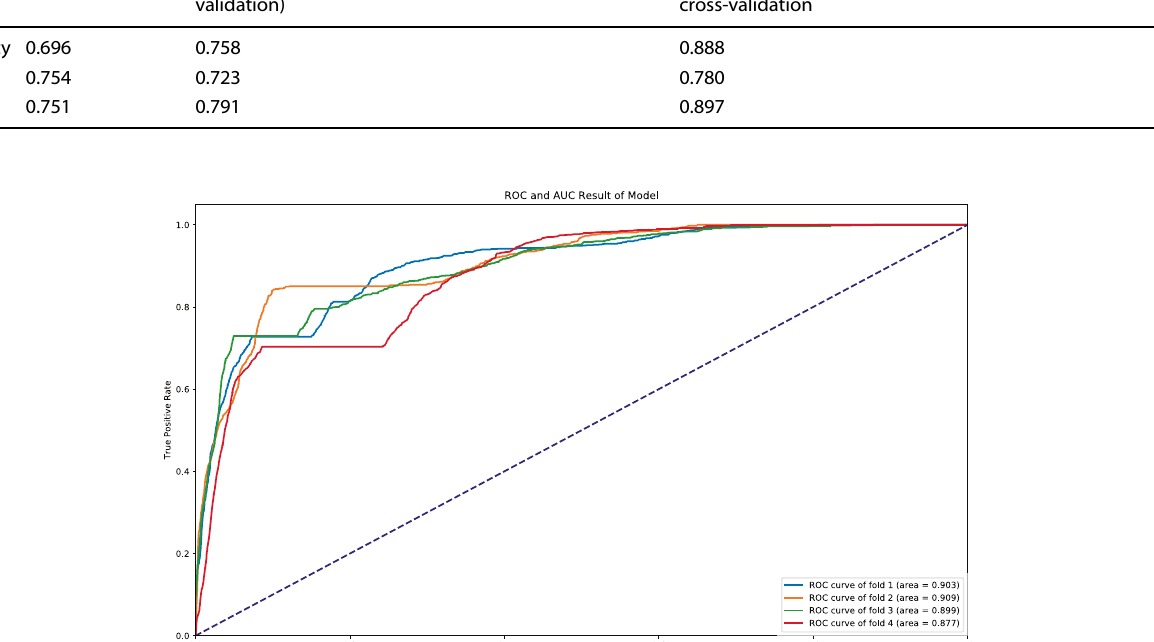
Proposed model (time sequence prediction with fourfold cross-validation